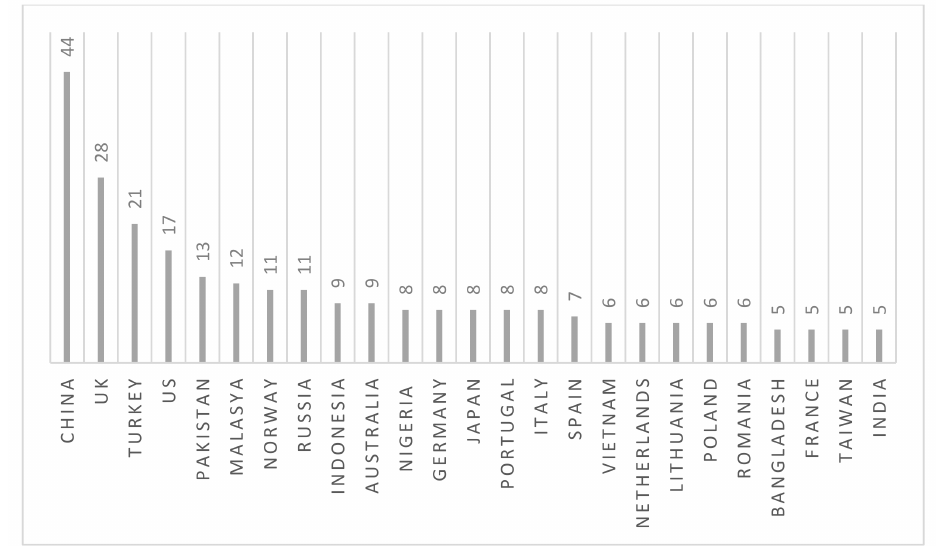
Figure 4. 25 Countries with more publications between 2008 and May